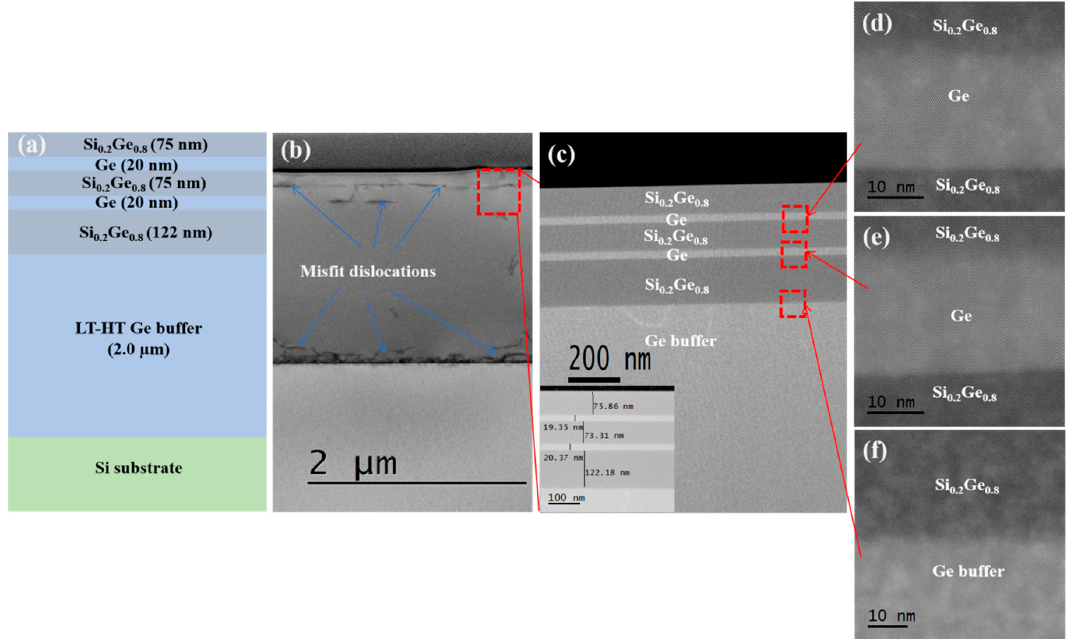
Figure 2. ( a ) The epitaxial stack structure diagram of Si/Ge buffer/Si 0.2 Ge 0.8 /Ge; ( b − c ) TEM images for the Si 0.2 Ge 0.8 /Ge multilayers grown on a 2.0 µm Ge buffer layer (sample C); the inset in ( c ) shows the thickness of each layer determined by TEM; ( d − f ) high-resolution images at interface between Si 0.2 Ge 0.8 and Ge.